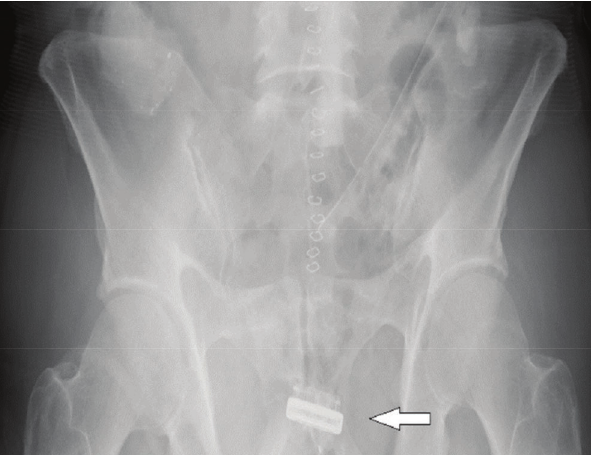
Figure 2 - Abdominal radiographs showing the preliminary healing of anastomotic leakage after 5 days post-operation with the ring (arrow) retained in the anastomosis before the ileostomy takedown.